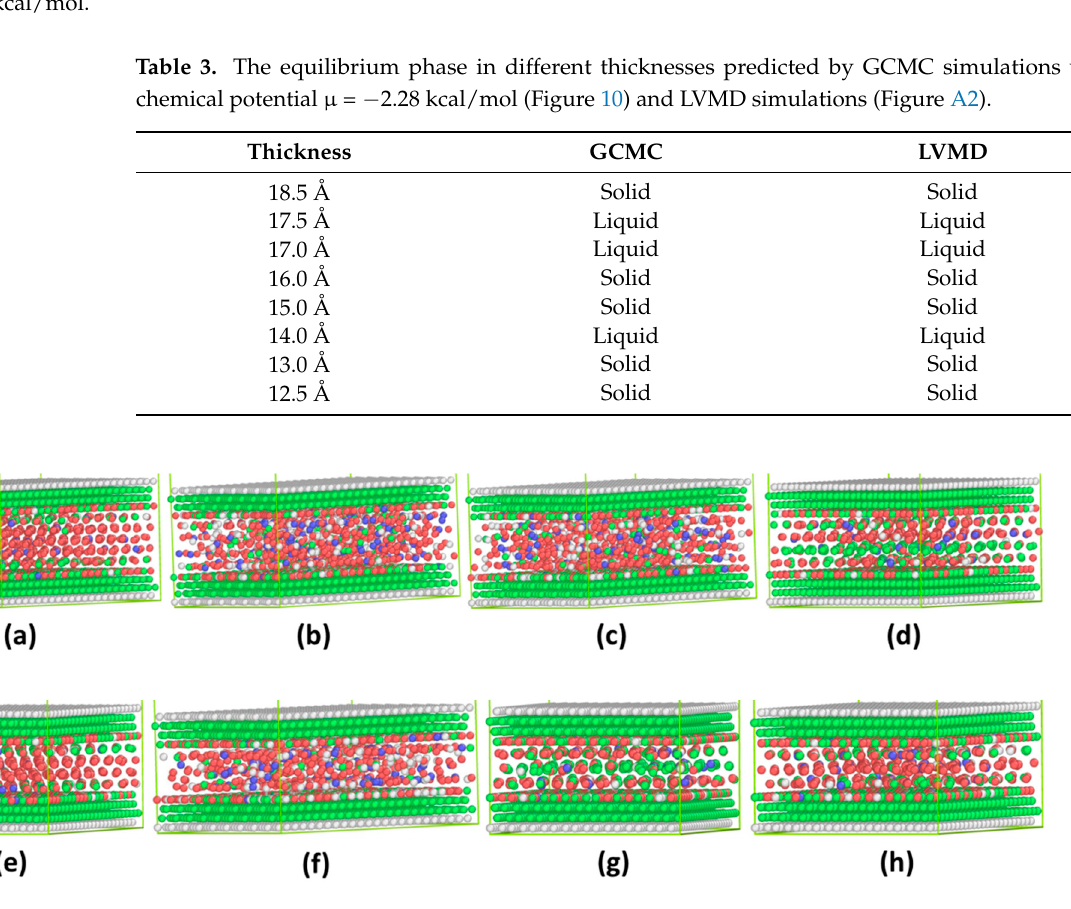
Figure 10. Equilibrium phases of argon molecules confined between two incommensurate contacts predicted in GCMC/MD simulations with chemical potential μ = − 2.28 kcal/mol for varying thicknesses: ( a ) 18.5 Å, ( b ) 17.5 Å, ( c ) 17.0 Å, ( d ) 16.0 Å, ( e ) 15.0 Å, ( f ) 14.0 Å, ( g ) 13.0 Å, and ( h ) 12.5 Å. They are consistent with those observed in LVMD simulations as shown in Figure A2.